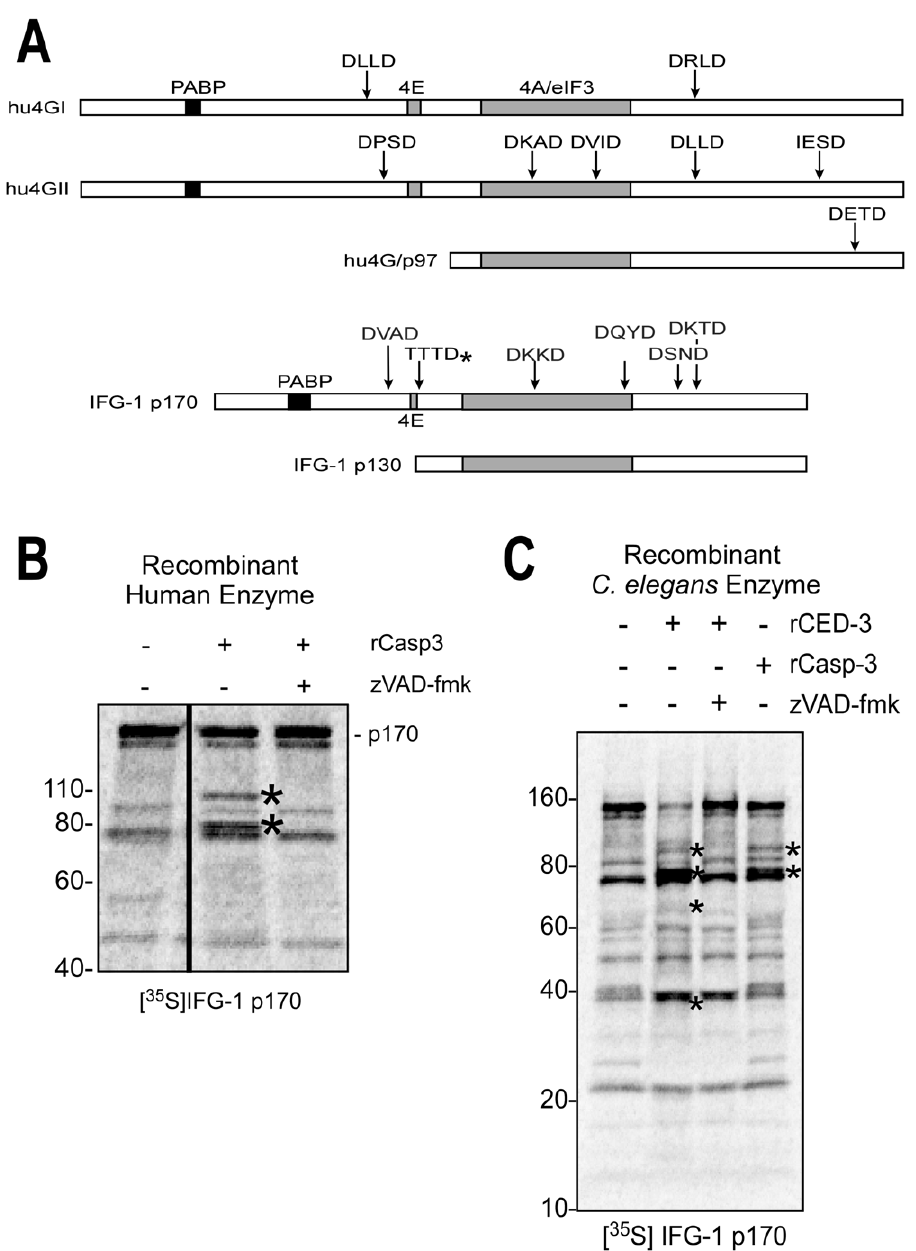
Figure 3. IFG-1 is a substrate for C.elegans CED-3. (A) Diagram depicting the known caspase-3 processed sites within human eIF4GI, eIF4GII, and p97 (upper three bars) and aligned IFG-1 p170 and p130 isoforms (lower bars) showing positions of predicted caspase sites (DXXD) as well as the actual, non-canonical C. elegans caspase (CED-3) cleavage site determined in this report (TTTD*). Relative positions of binding sites for major translation factor partners (PABP, eIF4E, and conserved eIF4A/eIF3 binding region) are also shown. (B) Cleavage of in vitro synthesized IFG-1 p170 by human caspase-3 (rCasp-3). Radiolabeled full length IFG-1 (1–1156) incubated with caspase-3 (2 h at 37 u C). IFG-1 p170 produced in vitro migrated substantially smaller ( , 150 kDa) than p170 detected in worm extracts by immunoblot. Aberrant migration is a common trait of eIF4Gs from most species, and may be due in part to posttranslational modifications in vivo . Smaller radiolabeled proteins in the untreated lane arise from internal translation starts in vitro . Two discreet cleavage fragments (*) were observed following caspase treatment. No processing of p170 was detected in the presence of the pan-caspase inhibitor z-VAD-fmk. (C) Recombinant [ 35 S]-labeled full length IFG-1 (1–1156) was incubated with C. elegans rCED-3 under similar conditions as in (B); human caspase-3 cleavage products were also resolved for size comparison. Proteolysis by both caspase-1 and rCED-3 was inhibited using z-VAD-fmk. The caspase-3-specific inhibitor, ac-DEVD-cho, was also effective (not shown). Both primary and secondary processed fragments are marked (*). doi:10.1371/journal.pone.0024444.g003 vitro digestion of radiolabeled full length IFG-1 p170. Cleavage by the enzyme natively found in the worm gonad. We next tested whether IFG-1 could be similarly targeted by the C. elegans main the C. elegans caspase was very efficient, and two major fragments effector caspase, CED-3. Using rCED-3 we performed similar in of approximately 95 and 80 kDa were observed representing N-